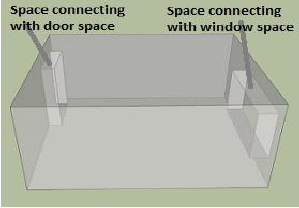
Figure 1. Spaces within room connected with opening spaces.